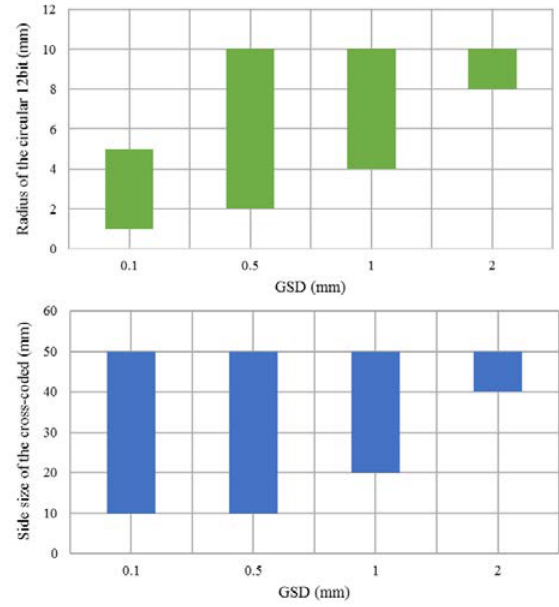
Figure 3. Correlation between GSD and target dimension using Circular 12bit (a) and Cross-coded tested